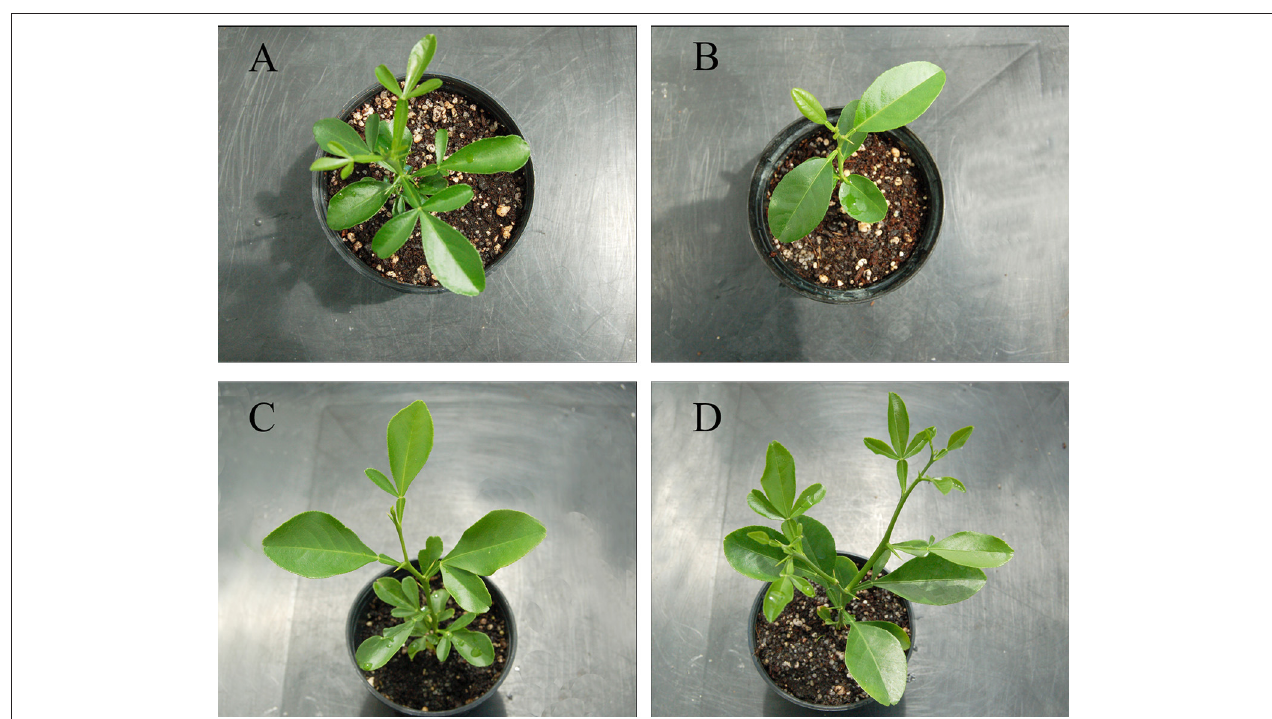
FIGURE 5 | Plants of (A) Carrizo citrange (CC ), (B) C. macrophylla (CM) and somatic hybrids (C) SMC-58 and (D) SMC-73 cultivated for 5 months in greenhouse conditions.